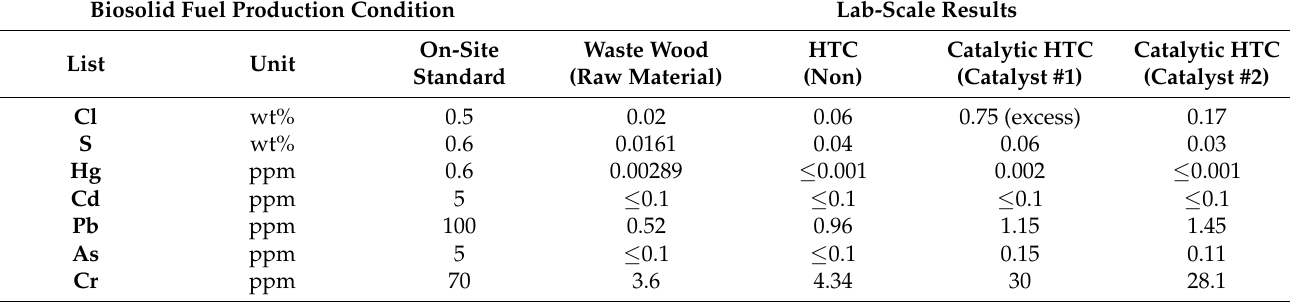
Table 5. Laboratory-scale HTC solid fuel analysis according to heavy metal and hazardous substance standards of biosolid